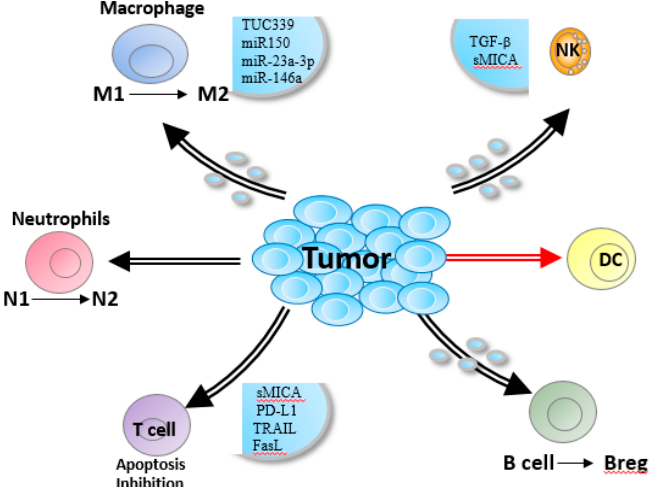
Figure 2. Roles of HCC-derived exosomes in regulating immune response. Exosomes suppress CD3 ζ -chain expression by T-cells and promoted their apoptosis by enriching for CD95L, TRAIL or galectin 9, and attenuate T-cell-mediated killing. Also, NK cell cytotoxicity is inhibited or blocked by TGF- β or soluble MICA/MICB in a NKG2D-dependent manner. Furthermore, exosomes can also promote the M2 macrophages, N2 neutrophils and Bregs.